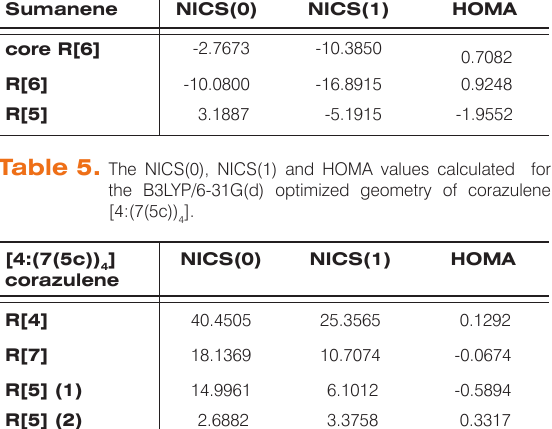
Table 4. The NICS(0), NICS(1) and HOMA values calculated for the B3LYP/6-31G(d) optimized geometry of sumanene.